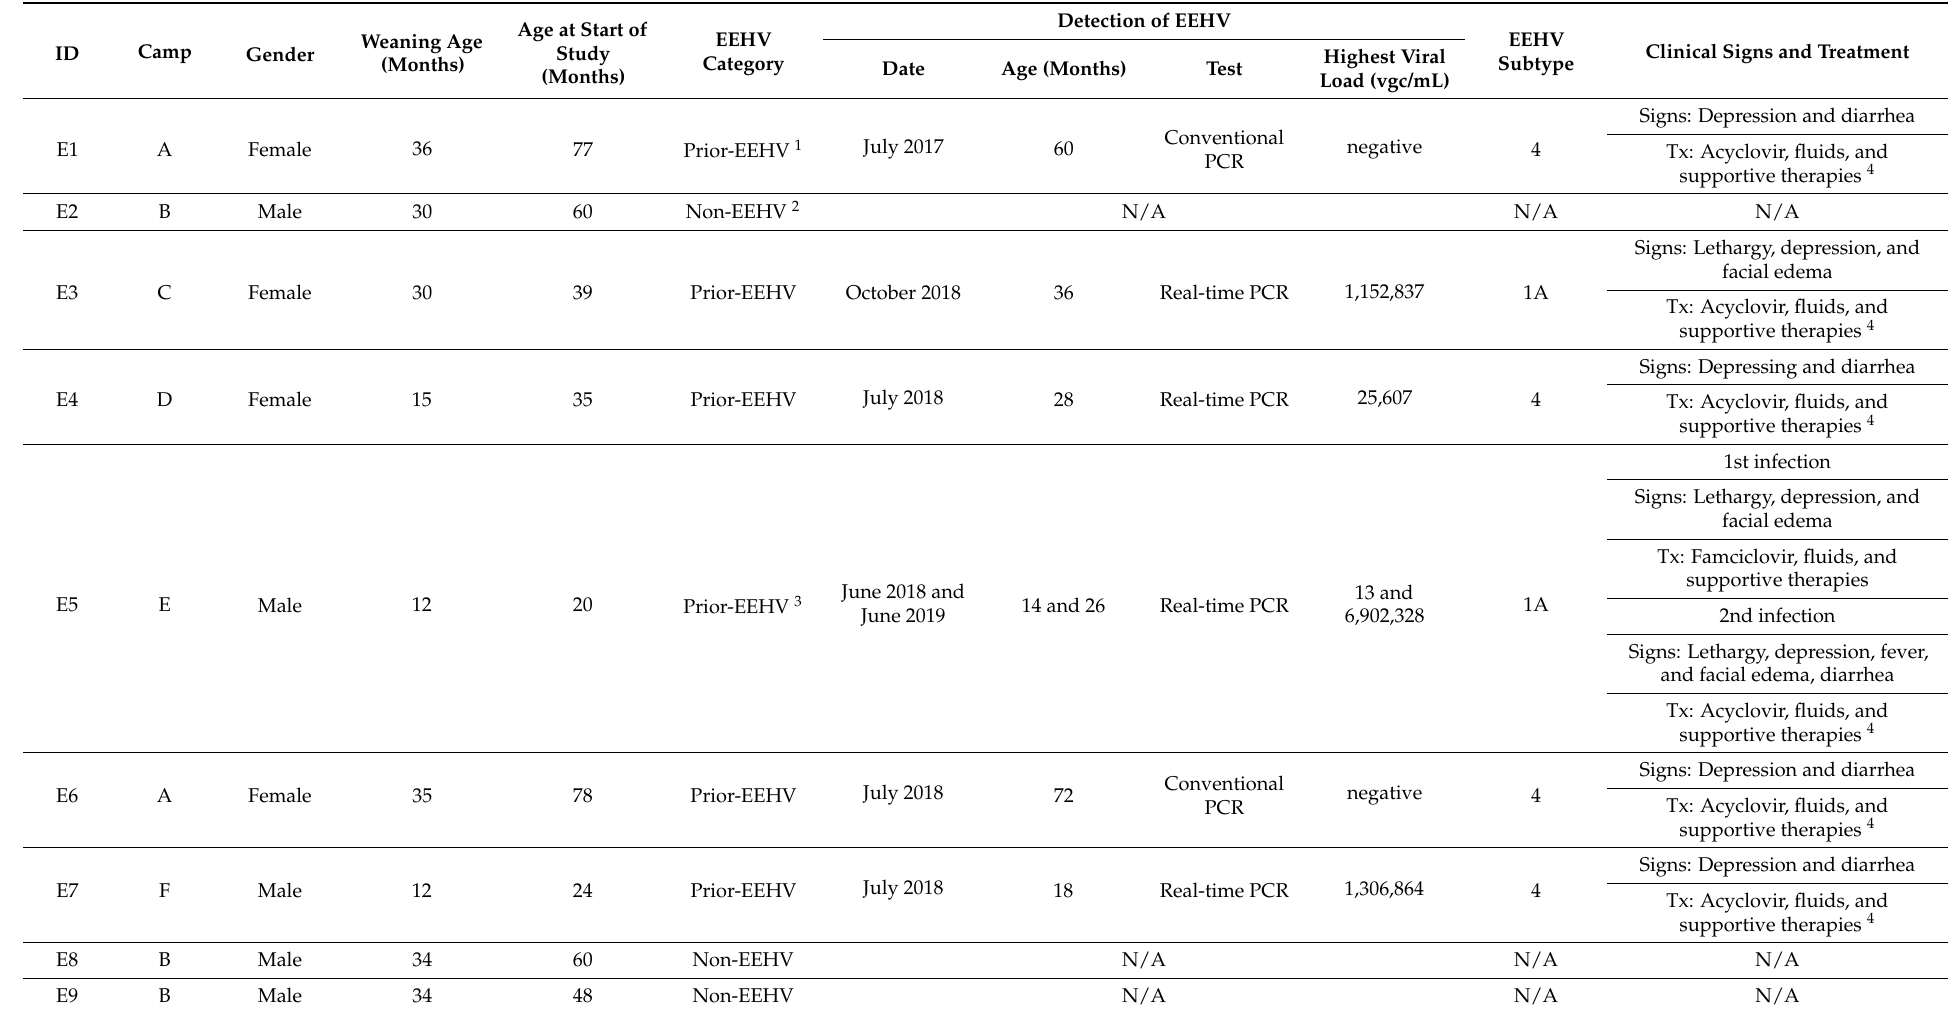
Table 1. Information on the elephant calves in the study and the EEHV